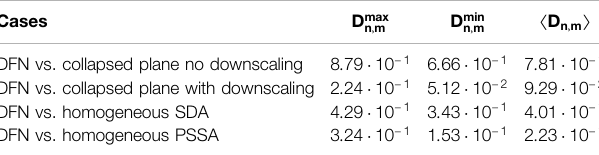
TABLE 3 | Results of the Kolmogorov – Smirnov (KS) test for the different variant simulations of the Conservative case . The KS test is run for each DFN realization and related collapsed planeorhomogeneousmodel andtheresultsare provided intermsofmaximum ( D max n , m ) ,minimum ( D min n , m ) andaverage ( 〈 D n , m 〉 ) test